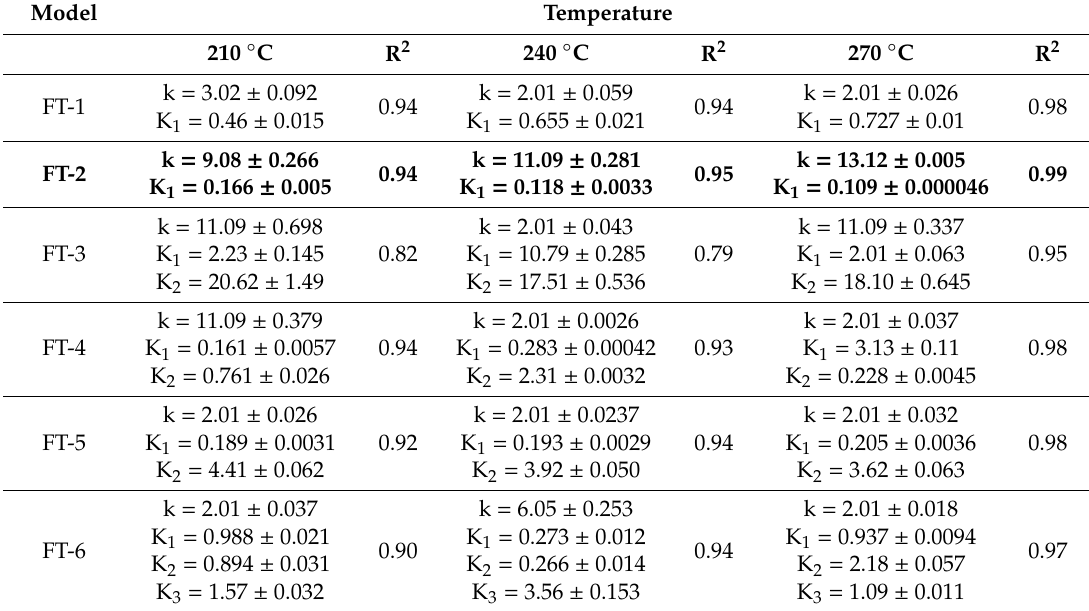
Table 6. Kinetic parameters obtained from proposed mechanisms for CoRu-SBA-15.